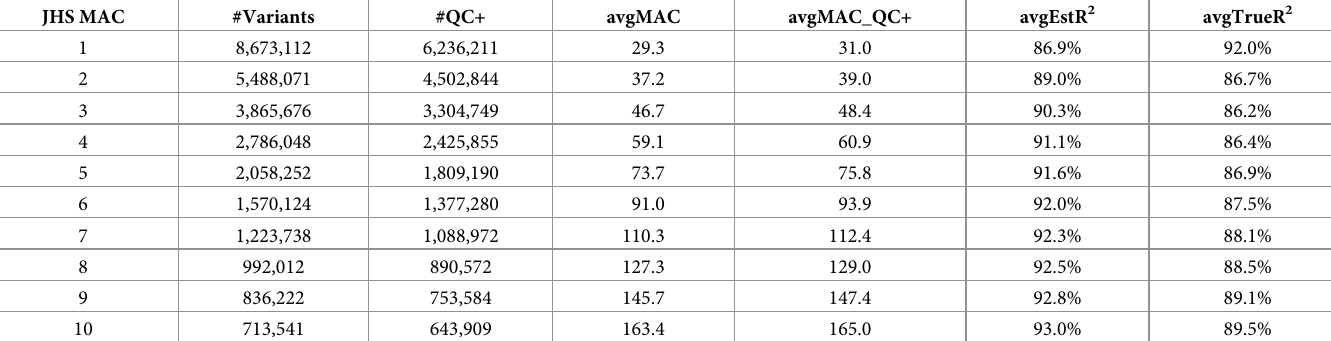
Table 2. Imputation quality for rare variants (minor allele count < = 10) in the Jackson Heart Study